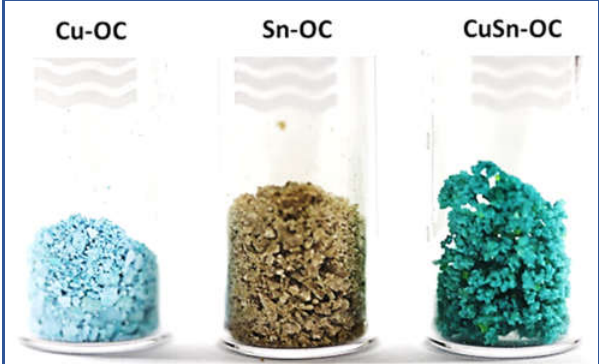
Nanomaterials 2023 , 13 , x FOR PEER REVIEW Figure 1. Photo images of Cu-OC, Sn-OC, and CuSn-OC. Figure 1. Photo images of Cu-OC, Sn-OC, and CuSn-OC.